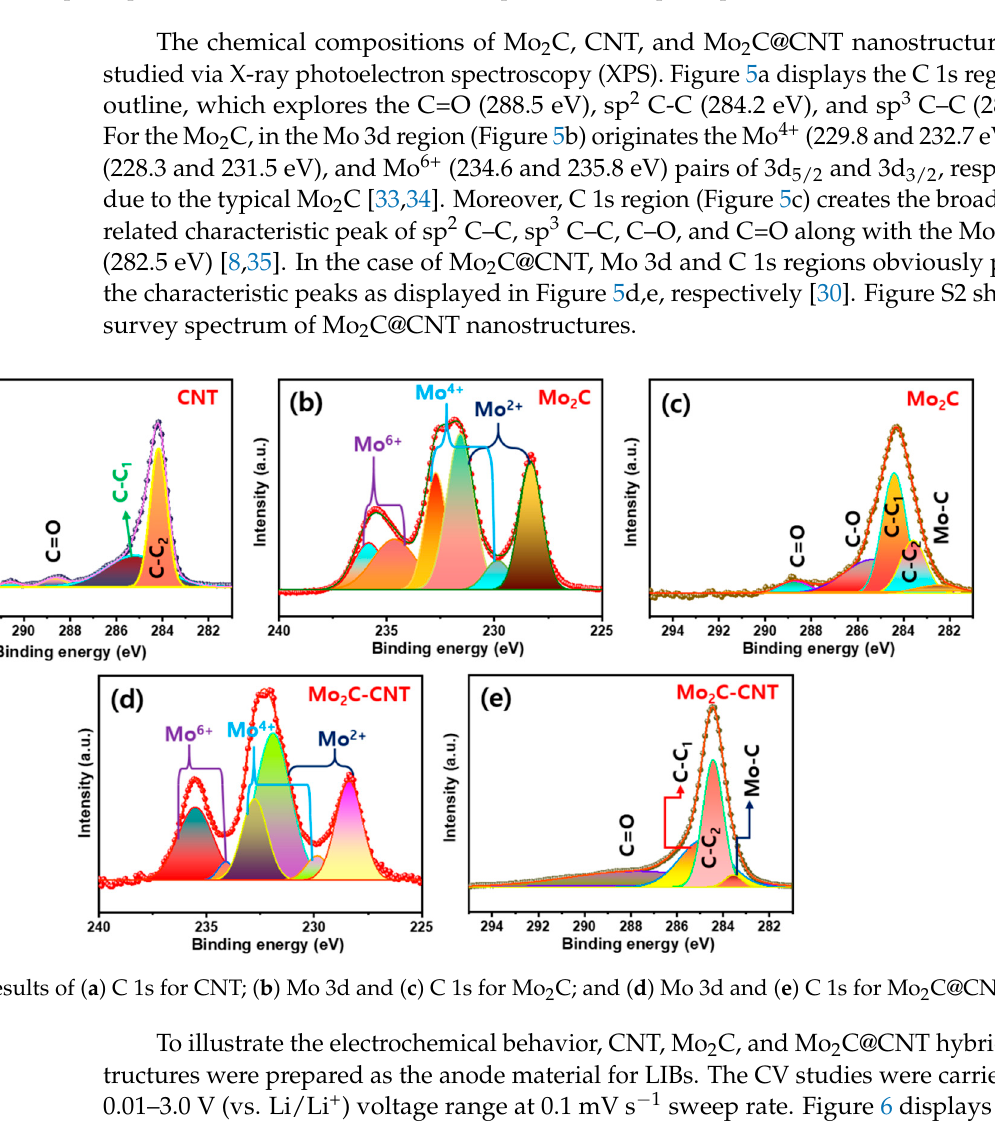
2 C; and ( d ) Mo 3d and ( e ) C 1s for Mo 2